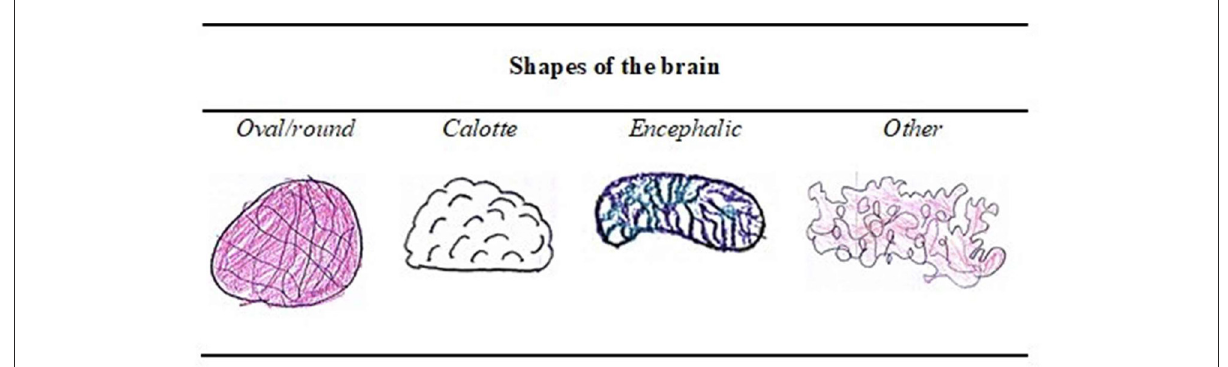
FIGURE2 Examples of brain drawings depicting each kind of shape.